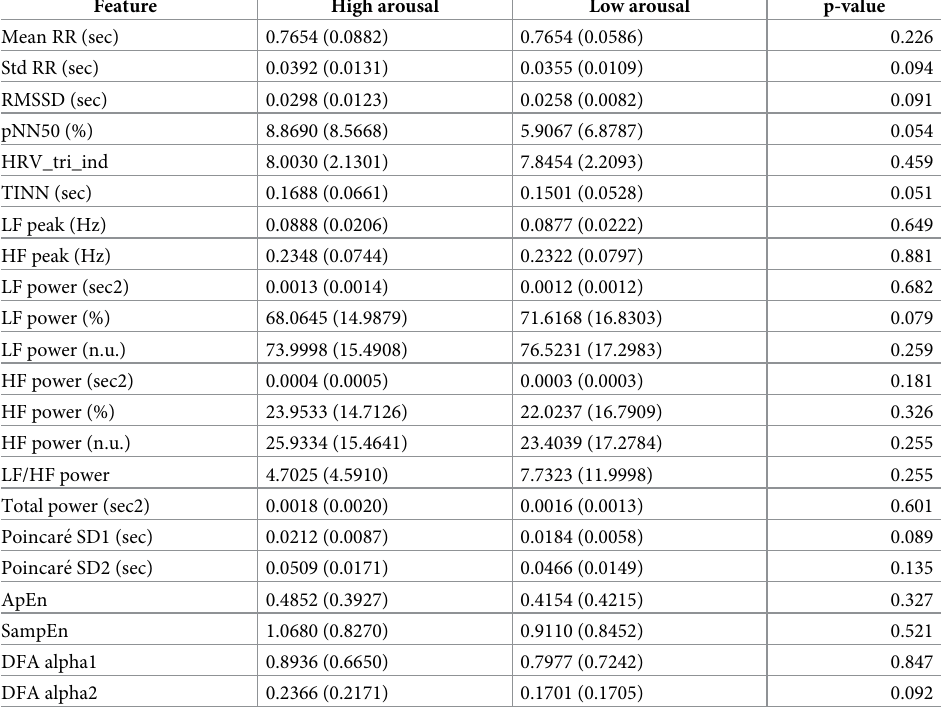
Table 3. HRV responses in the virtual museum in terms of arousal levels.